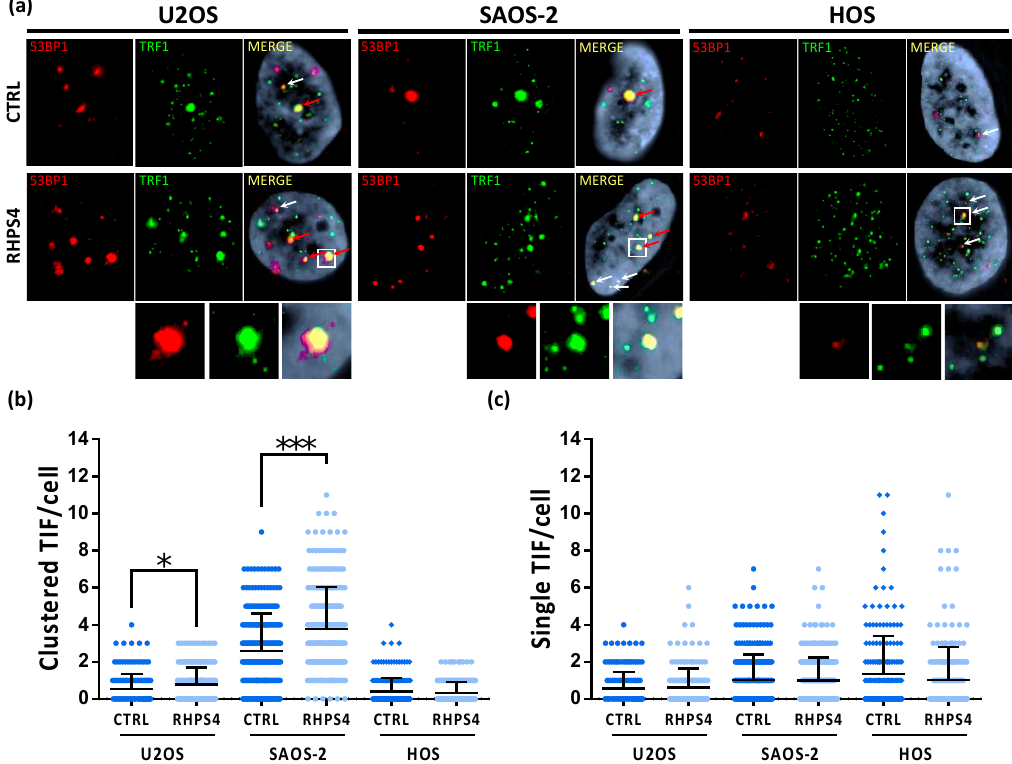
Figure 3. ( a ) Telomere dysfunction induced foci (TIFs) observed by immunofluorescence in osteosarcoma cell lines after 120 h treatment with RHPS4. For each line and condition, single channels (53BP1 protein signals in red and TRF1 protein signals in green) and merged images are illustrated. White arrows indicate TRF1 (green) and 53BP1 (red) colocalizations; red arrows indicate the dysfunctional telomeres aggregation (telomere clusters). ( b ) Dotplot of telomeres clusters formed in ALT cell lines by dysfunctional telomeres aggregation. RHPS4 treatment induces a significant increase in both ALT lines, but not in HOS. ( c ) Dotplot of single colocalizations between TRF1 and 53BP1 showing telomeric localization of DNA damage.. The middle bar denotes mean and the bars above and below the mean denotes standard deviation. * p < 0.05, *** p < 0.001 (Student’s t -test).